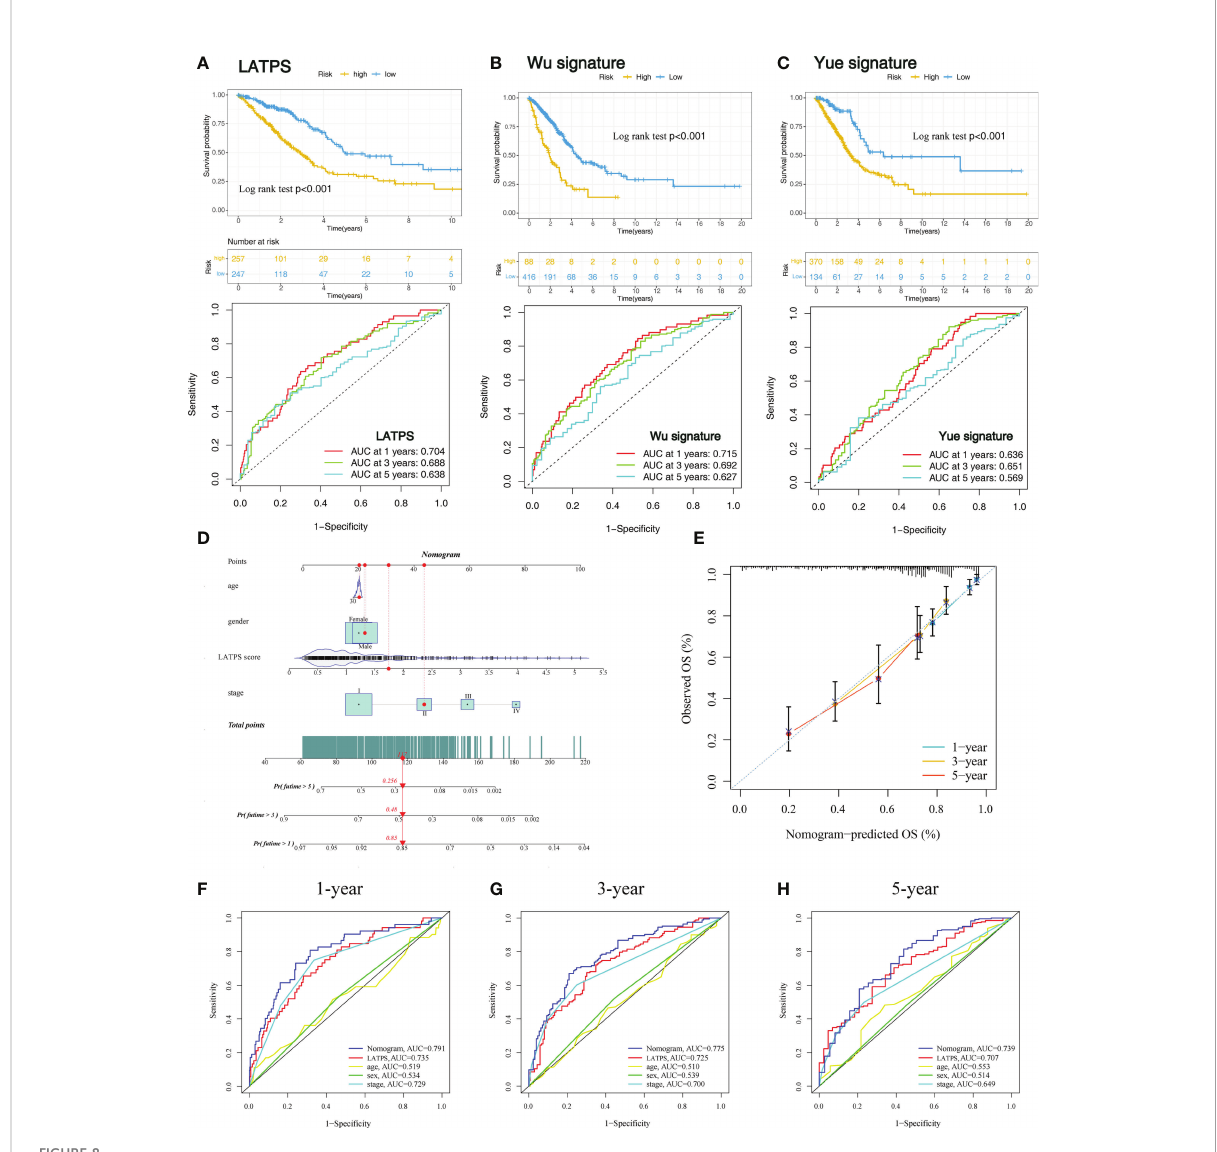
FIGURE 8 Comparison of the LATPS with other published gene signatures and construction of a nomogram. Kaplan – Meier curve and the ROC curve of (A) LATPS, (B) Wu signature, and (C) Yue signature. (D) Nomogram based on the LATPS and clinical information of patients with LUAD. (E) Calibration curve of the nomogram used for predicting OS at 1, 3, and 5 years. Time-dependent ROC curves analysis of the nomogram and clinicopathological factors in predicting (F) 1-, (G) 3-, and (H) 5-year OS. LATPS, LUAD tumor microenvironment prognostic signature; LUAD, lung adenocarcinoma; OS, overall survival; ROC, receiver operating